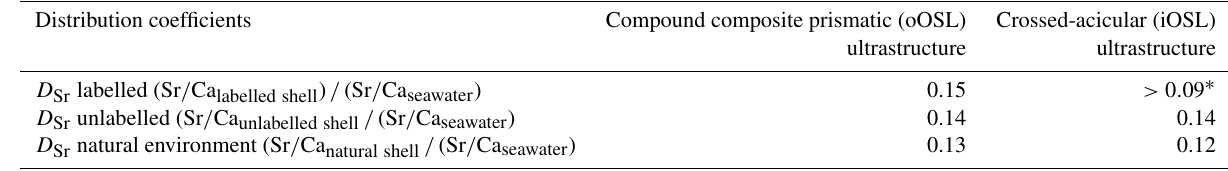
Table 3. Distribution coefficients of Ca and Sr between shell and seawater for both ultrastructures as well as for pulse Sr-labelled and unlabelled conditions. Concentrations for Ca and Sr in shells are from Table 1, while seawater values are mean ocean